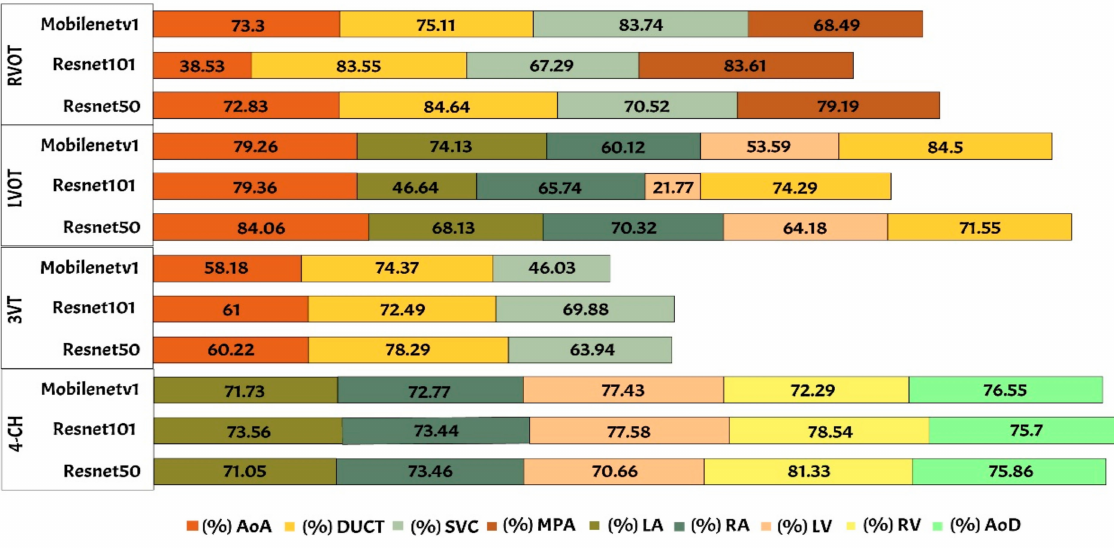
Figure 8. The IoU performance in heart chamber segmentation in four fetal heart standard views.